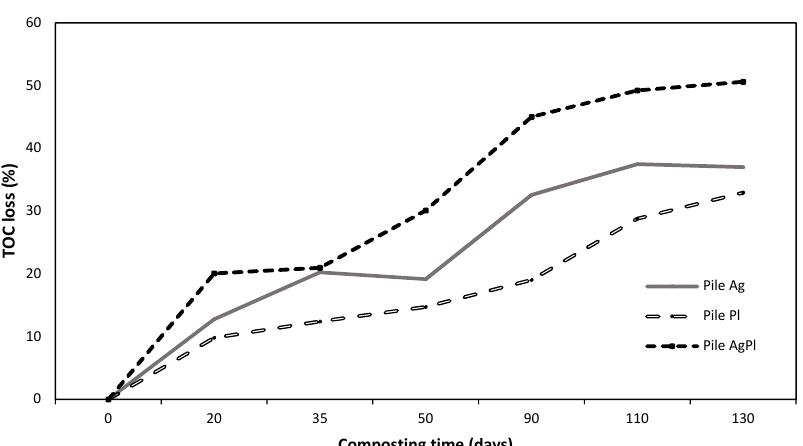
Figure 1. Percentage of total organic carbon losses during the composting process of the different piles. 100% A. bisporus (Pile Ag), 100% P. ostreatus (Pile Pl), and 70% A. bisporus: 30% P. ostreatus (Pile AgPl). Table 2. Heavy metal concentration of 100% A. bisporus (Ag), 100% P. ostreatus (Pl), and 70% A. bisporus: 30% P. ostreatus (AgPl) composts.